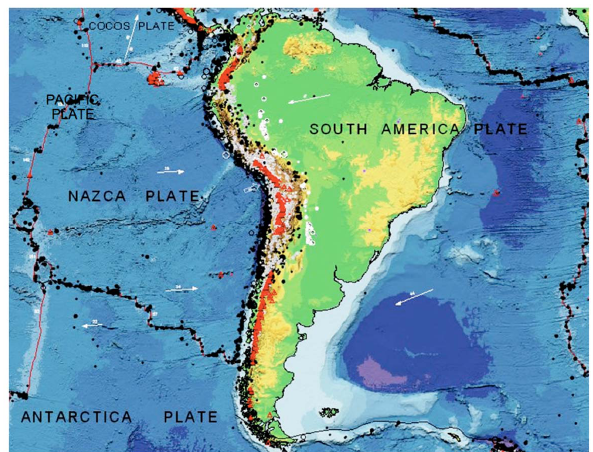
Fig. 2. The Andean Volcanic Arc (AVA) has formed by the subduction of the Nazca and Antarctica Plates beneath the South America Plate. The present-day AVA is well expressed by the string of Andean volcanoes that have been active since the Holocene, as delineated by the solid and open red triangles on this portion of the world plate tectonics map of Simkin and others (2006). The circles (black, white, and open) mark earthquakes of magnitude 5 or greater; the segmented red lines show divergent plate boundaries.